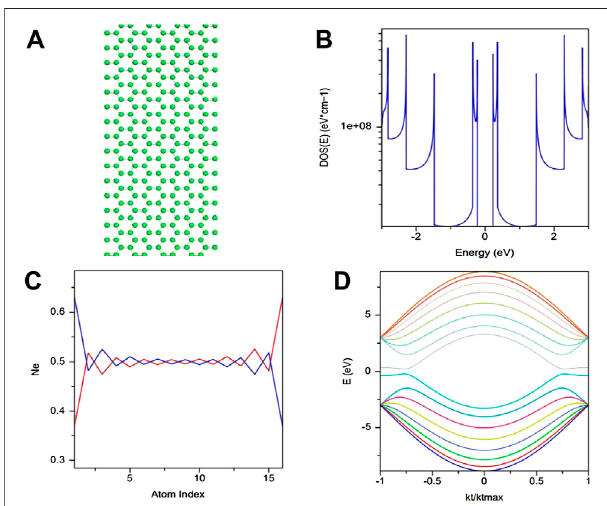
FIGURE 12 | When edge effects are considered, (A) GNR type-A with tight-binding energy (3 eV), c-c spacing (1.42 A ° ), chirality (8,8), (B) density of states plotted with energy, (C) spin resolved density with atom index, and (D) band structure. We have plotted these results from the nanohub software of Purdue University [4].